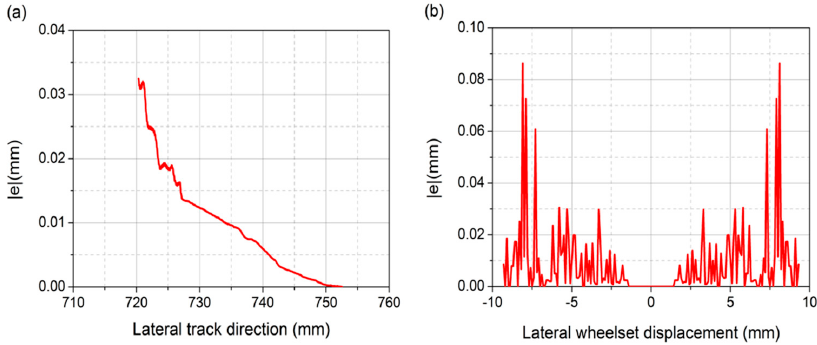
Figure 11. Absolute value of the error e . ( a ) rail profile; ( b ) rolling radii difference distribution.